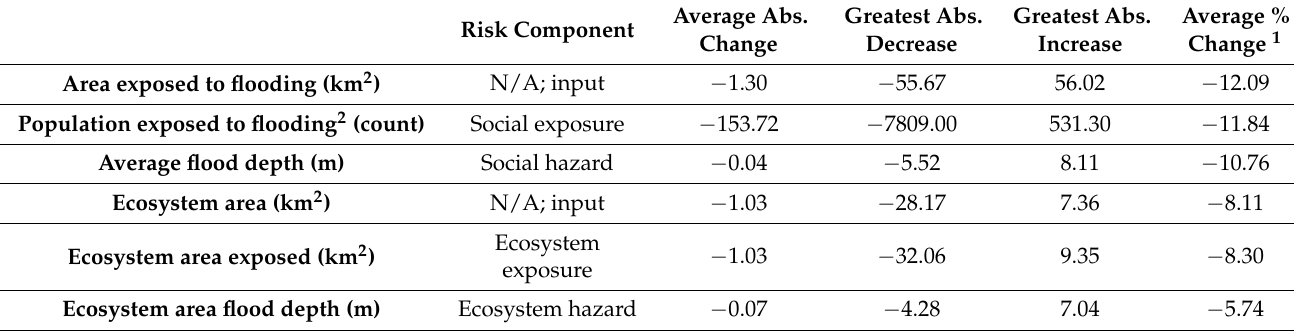
Table 3. Changes among Mississippi Delta census tracts comparing current ecosystem area data and current coastal flood area and depth data (from baseline 2015 data) with corresponding data for 10-year medium environmental scenarios. Average changes (absolute and relative) across the delta as well as the tract values for greatest absolute decrease and increase in risk components are